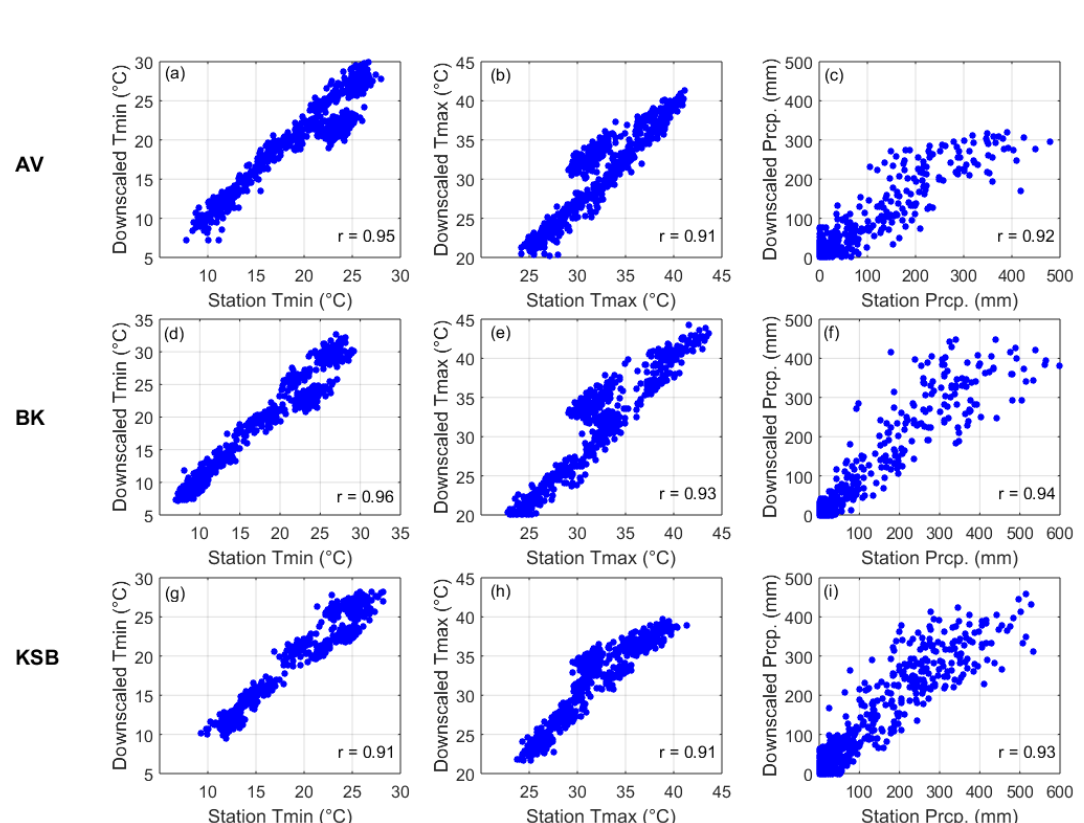
Figure 4. Scatterplots of basin averaged monthly mean values maximum temperatures (Tmax), minimum temperatures (Tmin) and precipitation (Prcp.) obtained from downscaled data and India Water Portal stations data between 1950 and 2002. Each row of scatterplots relates to each of the study area.